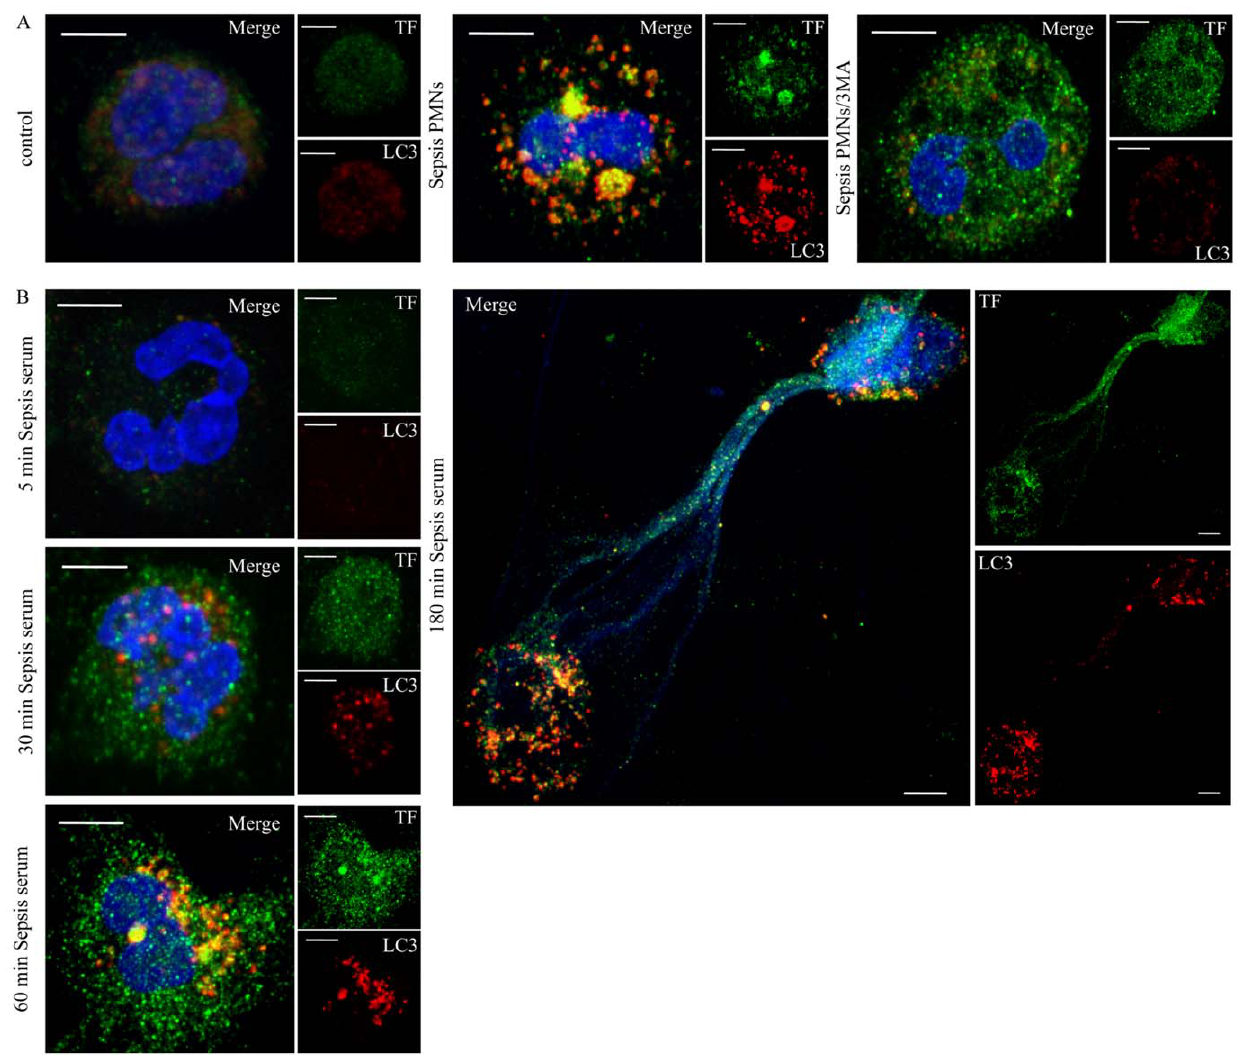
Figure 6. Localization of TF in LC3B positive structures in sepsis neutrophils and control neutrophils treated with sepsis serum. (A) Sepsis neutrophils were incubated for 1 h and the intracellular distribution of TF and LC3B was assessed by confocal microscopy (z stack analysis, 0.3 m m per plane). Formation of LC3B positive punctuated structures in sepsis neutrophils (Sepsis PMNs) and colocalization of TF with LC3B. Treatment with 3-MA (Sepsis PMNs/3MA) inhibited the formation of LC3B positive structures and resulted in a disperse TF staining. (B) TF and LC3B localization in control neutrophils treated with sepsis serum at various time points. (DNA labeled with DAPI; blue, anti-TF mAb; green, anti-LC3B mAb; red) (original magnification 1000 6 ). One out of three independent experiments is shown in A–B. Scale bar represents 5 m M in A–B.